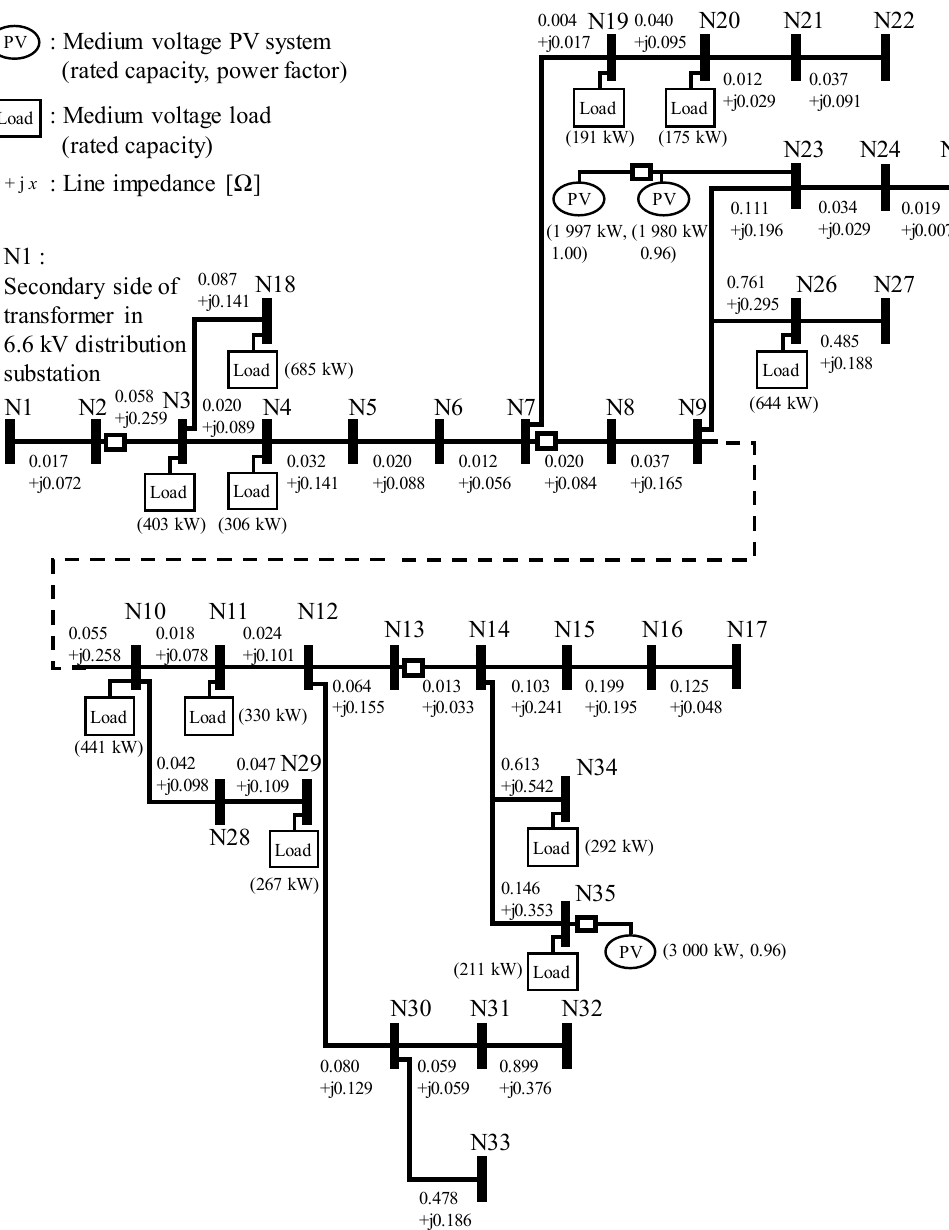
Figure 5. MV distribution system model that corresponds to the actual distribution feeder shown in Figure 1a.